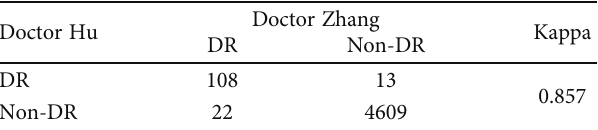
Table 2: The kappa coe ffi cient between two